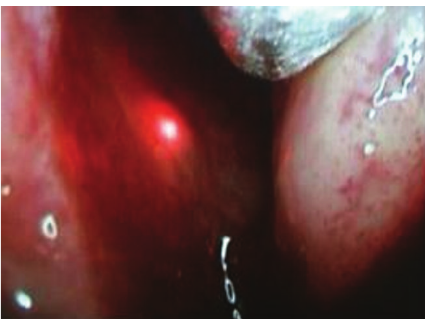
Figure 1: The red light reflex of the fiber is clearly seen on the nasal wall of the middle turbinate.